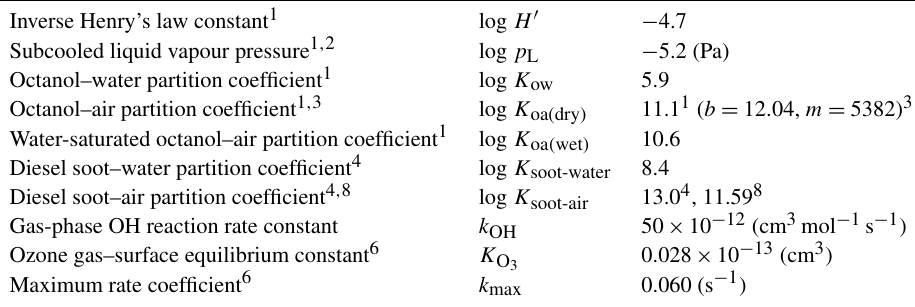
Table 1. Physicochemical parameters and reaction rate coefficients used in the WRF-CMAQ-BaP model. Inverse Henry’s law constant 1 log H